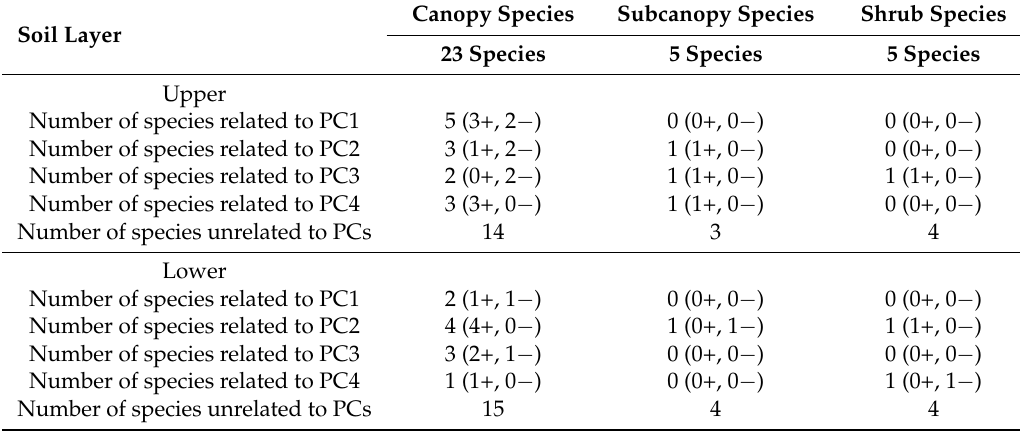
Table 5. Species distribution-PC associations examined by the homogeneous Thomas process in different growth groups.